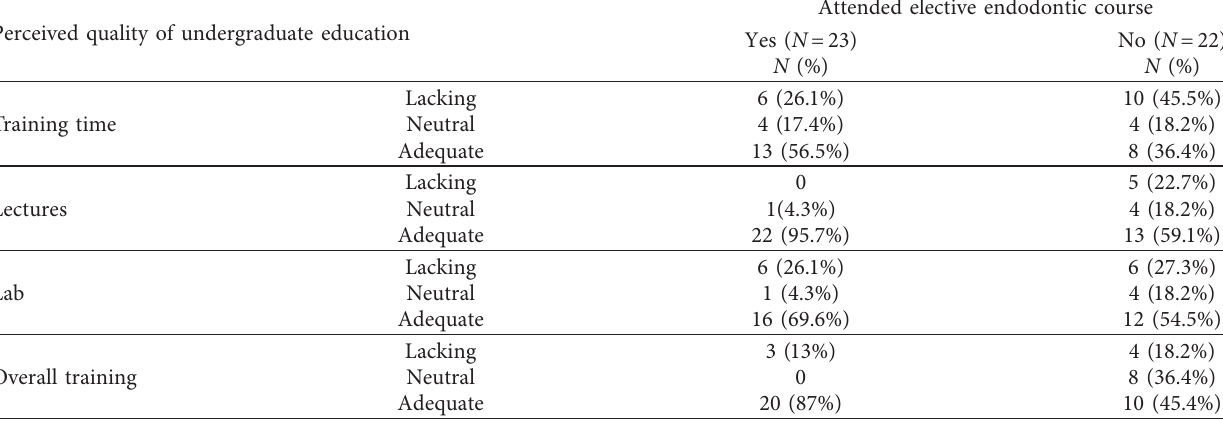
Attended elective endodontic